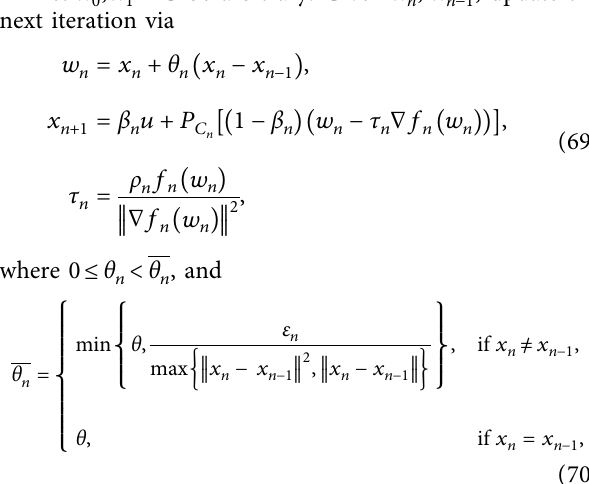
Algorithm 2. Choose positive sequence ε n 􏼈 􏼉